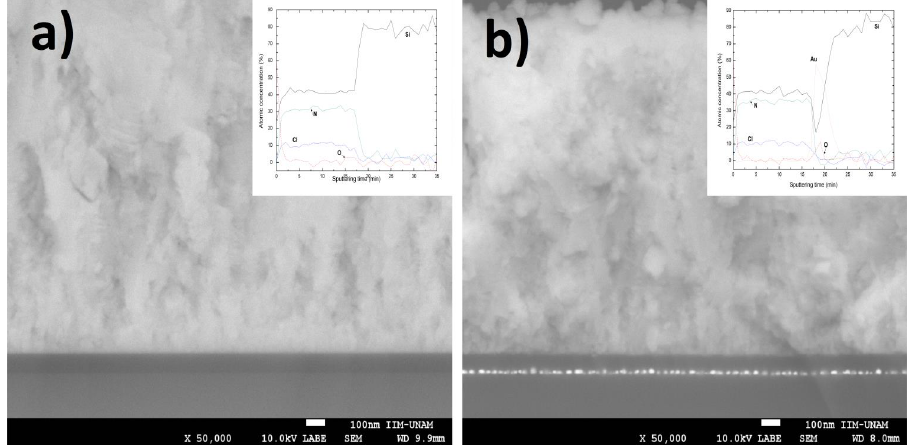
Figure 4. Cross-sectional views by SEM of the ( a ) PR2 (p-Si/SiNx/SiQDs/ZnO-Al) and ( b ) P2 (p- Si/AuNPs/SiNx/SiQDs/ZnO-Al) structures, respectively. The different silicon nitride layers (SiNx and SiQDs) are not distinguishable by this microscopy technique. The depth profiles of these samples from top silicon nitride to silicon substrate are inset of each figure.